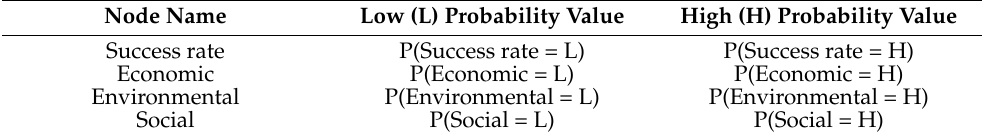
Table 14. Probability table of the Criteria.